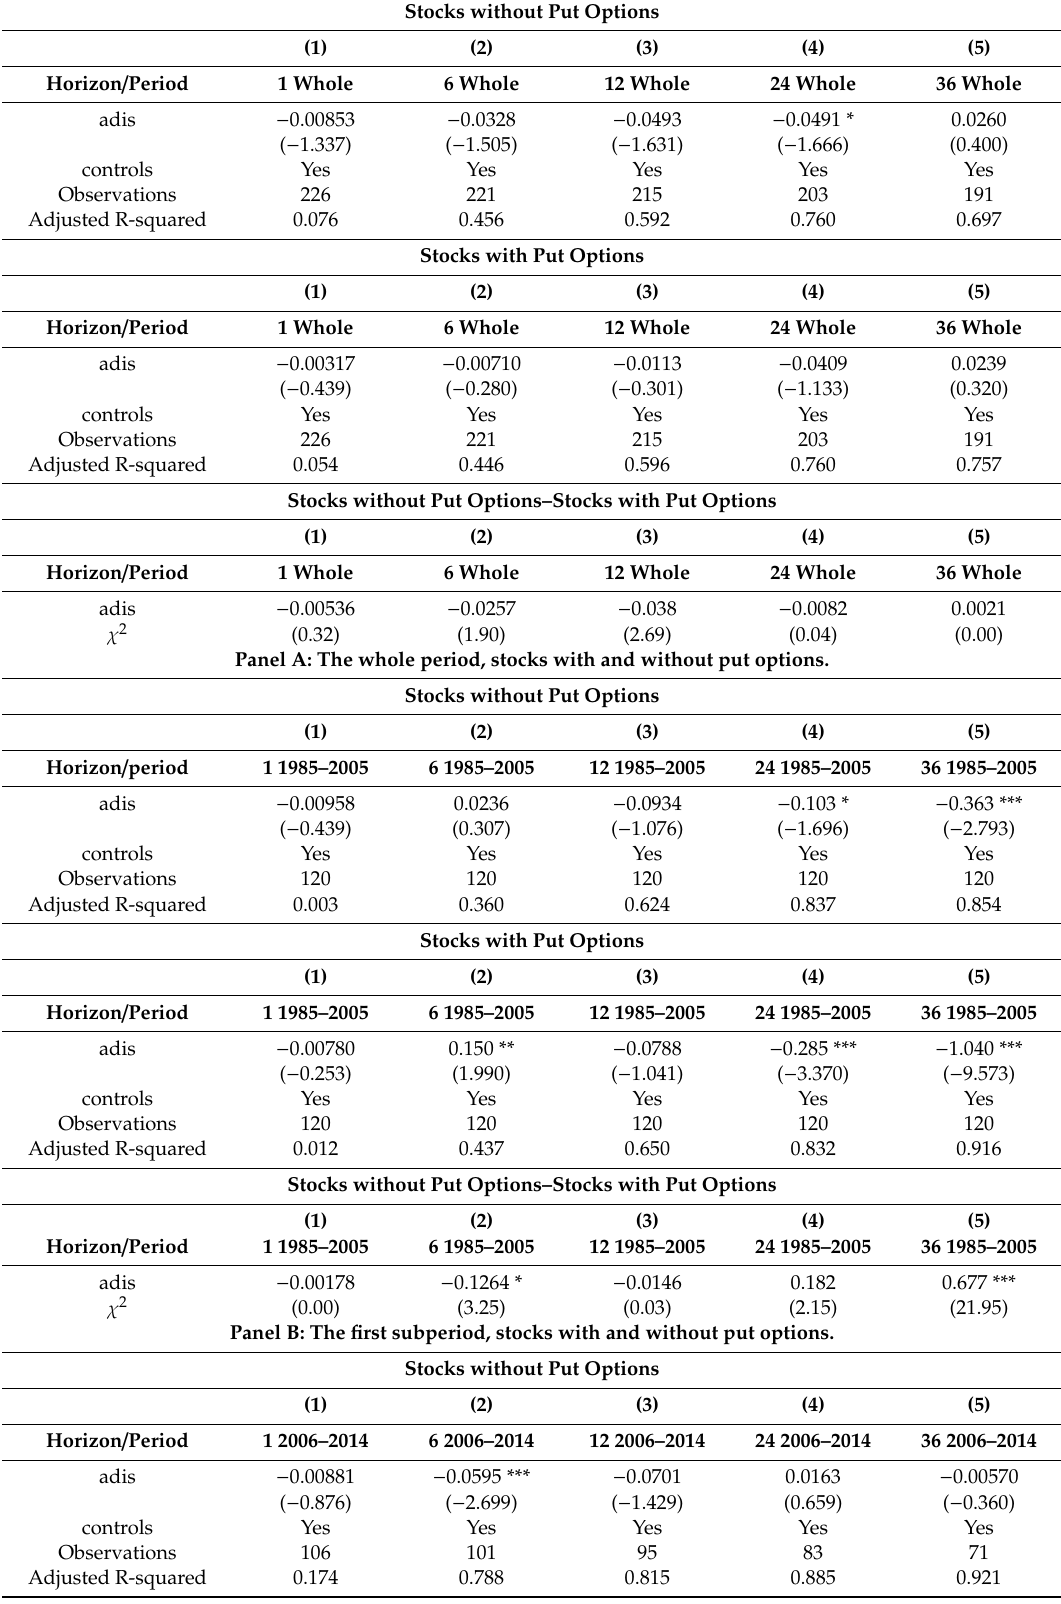
Table 9. Comparison of the dispersion e ff ect between stocks with and without put options.